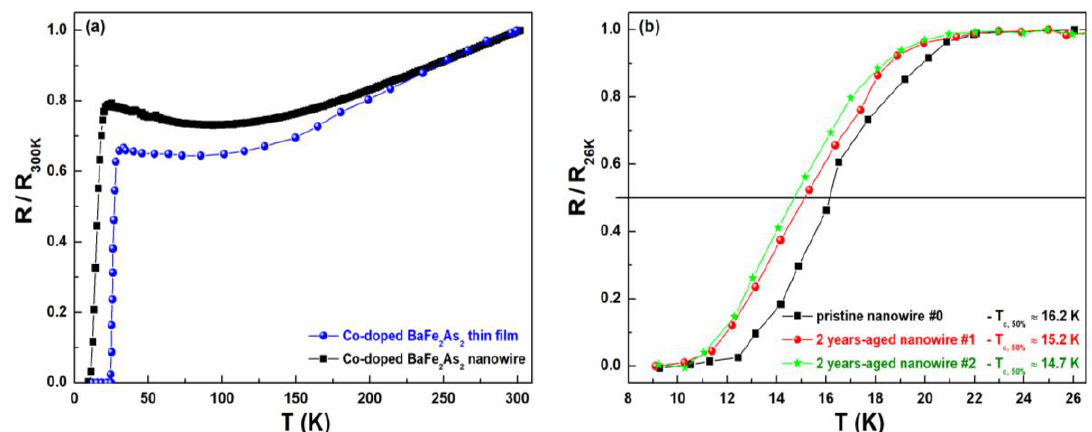
Figure3. Resistanceversustemperatureplots.( a )Thedatarefertotheresistanceofthinfilms(bluecircles) and of nanowires (black squares), normalized to their room temperature values. ( b ) An enlargement of the superconducting transition region is shown, where the resistances, normalized to their normal state values at T = 26 K, are reported for pristine and two years-aged